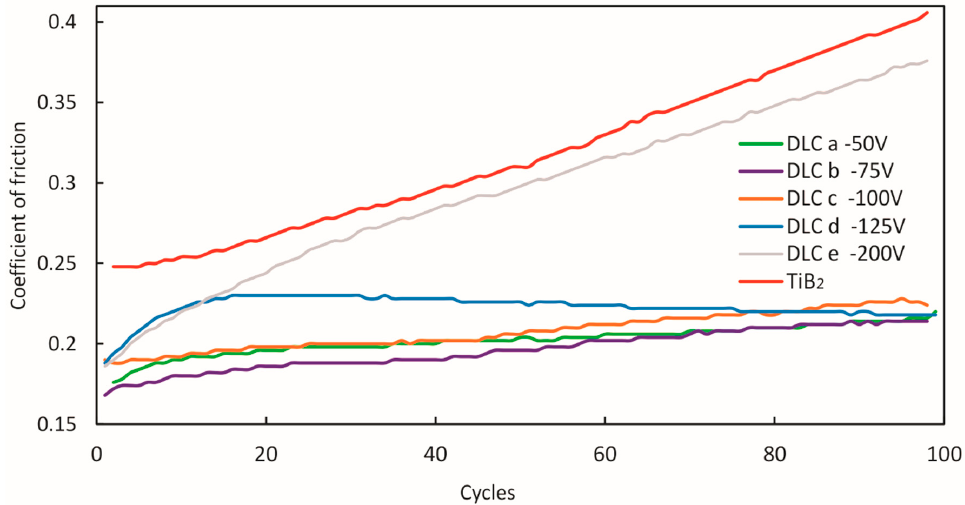
Figure 3 Figure 3. Friction coefficient vs number of cycles for DLC coatings and reference TiB Test conducted by bi-directional scratch test using a fixed tungsten carbide (WC) ball with 5 mm diameter sliding against a coated sample. Constant load 5 N applied for 10 mm